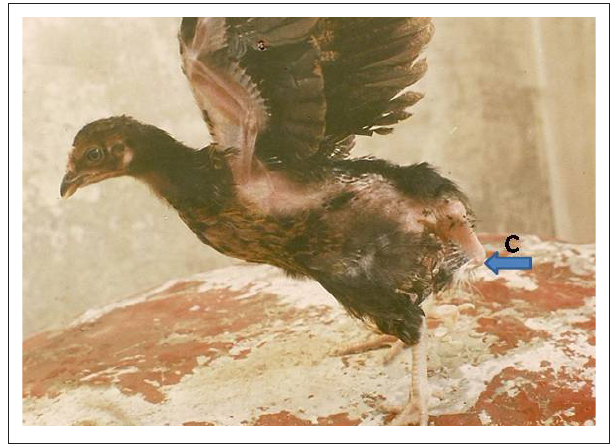
c, polymelia can be seen in the left lateral view the rudimentary wing. FIGURE 2: Polymelia in an eight-week-old Nera black chicken, seen from the left side.